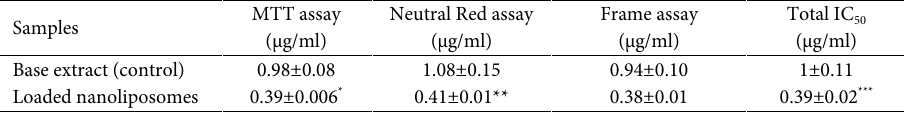
Table 2. IC 50 values of base and nanoliposomal extract of E. elaterium on gastric cancer cell line after 24 h